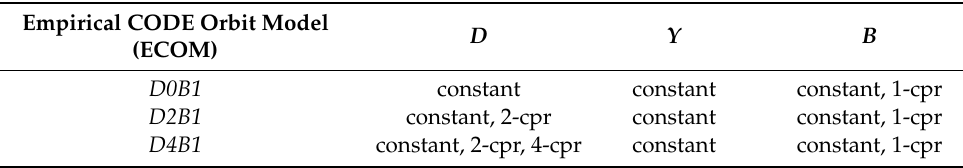
Table 1. Estimated empirical parameters in satellite–Sun direction ( D ), direction along the satellite’s solar panels axis ( Y ), and completion of the orthogonal right-handed system ( B ) for the original Empirical CODE Orbit Model (ECOM) and the extended Empirical CODE Orbit Model (ECOM2). Cycles-per-revolution is denoted as cpr.